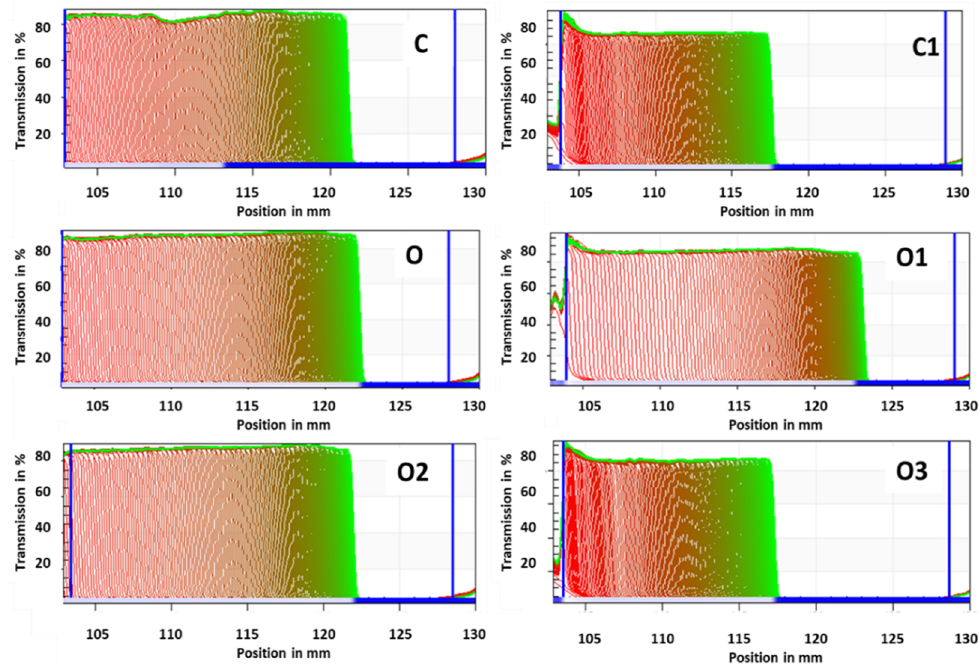
Figure 7. Influence of different tea infusions on the yoghurt’s transmission profiles presented, enabling LUMi Sizer ® analysis. C, control; C1, control with 6% inulin; O, oolong tea; O1, oolong tea with 3% inulin; O2, oolong tea with 6% inulin; O3, oolong tea with 9% inulin.